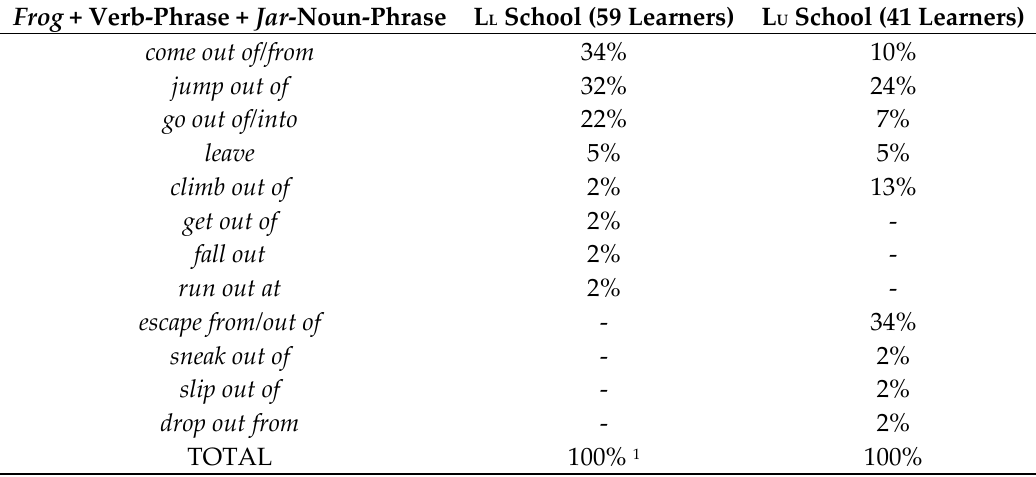
Table 3. Verb-phrases in the frog-leaves-jar scene at the Ladin lower (L L ) and upper (L U ) secondary